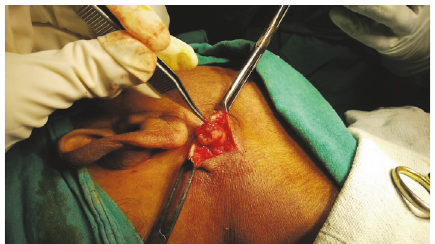
Figure 2: Intraoperative photograph showing enucleation of the parotid